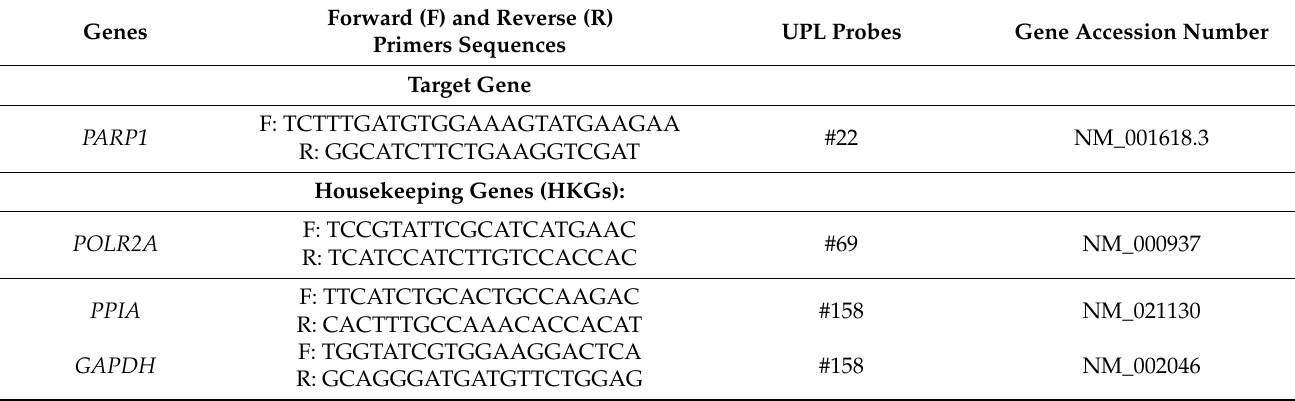
Table 1. PARP1 target gene-specific sequences and housekeeping genes (HKGs) and their respective FAM-labeled universal probe library (UPL) probes and gene association numbers for real-time